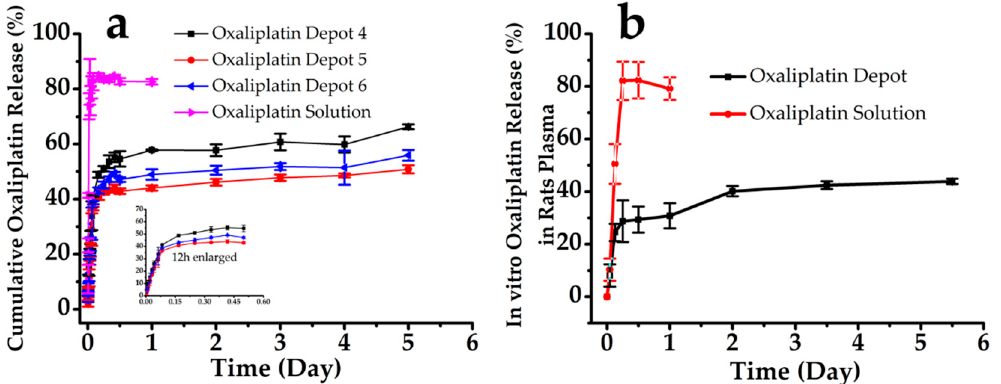
Figure 5. In vitro oxaliplatin release from oxaliplatin-loaded MVL depots and the oxaliplatin solution: ( a ) 5% dextrose solution and ( b ) rats plasma. Study was carried out at 37 ± 0.5 ◦ C, and data are presented as the mean ± SD ( n = 3).